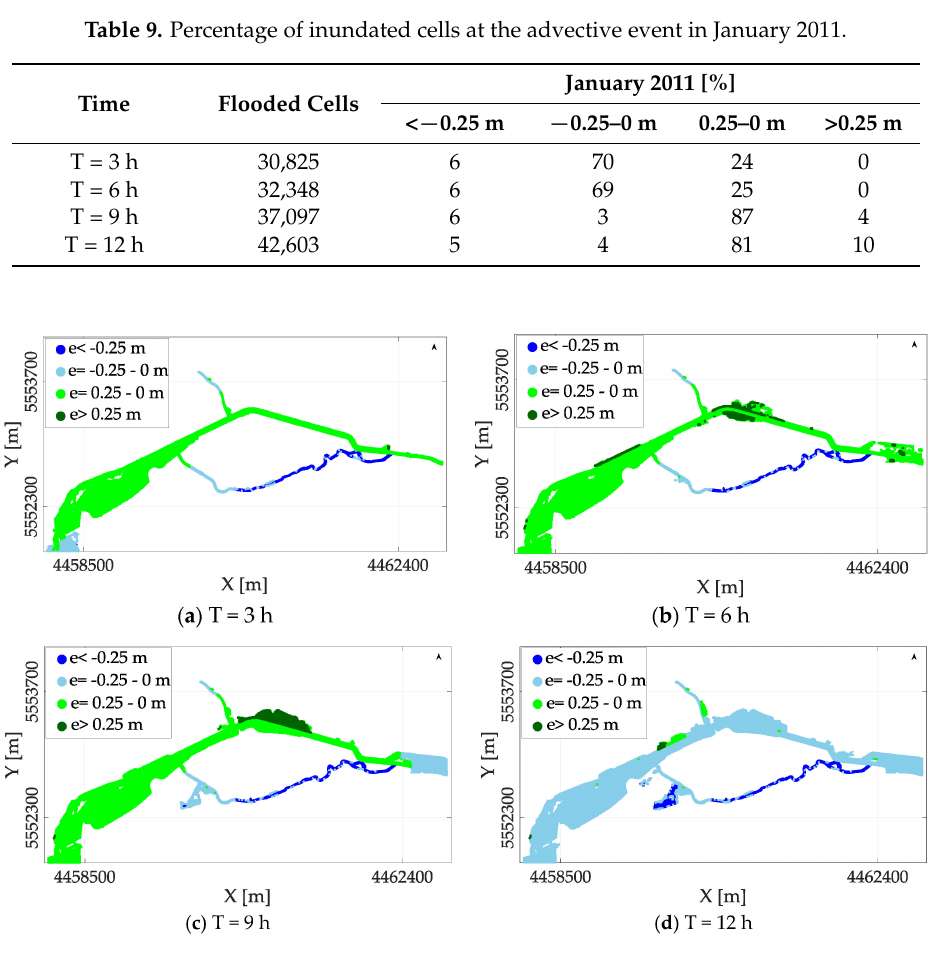
Figure 11. Water depth error between offline and online for February 2005: ( a ) T = 3 h, ( b ) T = 6 h, ( c ) T = 9 h and ( d ) T = 12